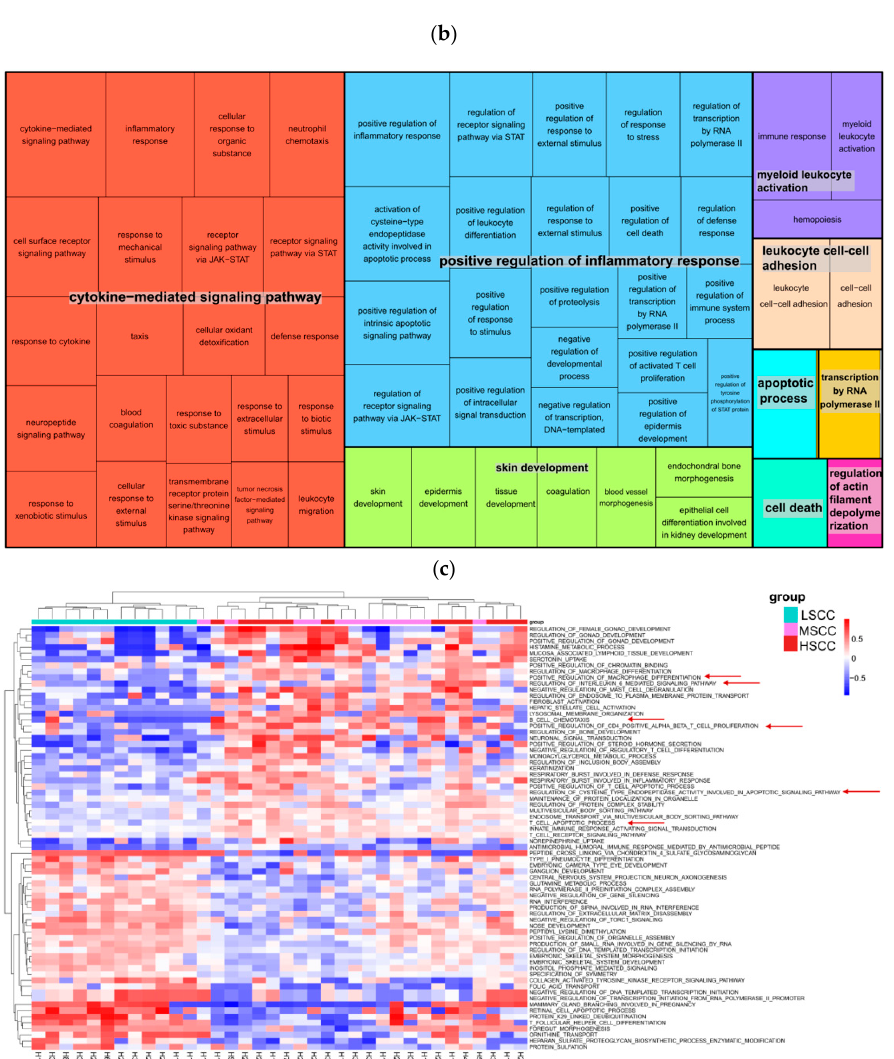
Figure 7. Gene functional analyses. ( a , b ) Bubble diagram and treemap illustrating the top 7 KEGG pathways and GO terms enriched by DEGs with the same regulation direction in two sites. ( c ) Heatmap showing the result of GSVA using biological process − related GO terms.